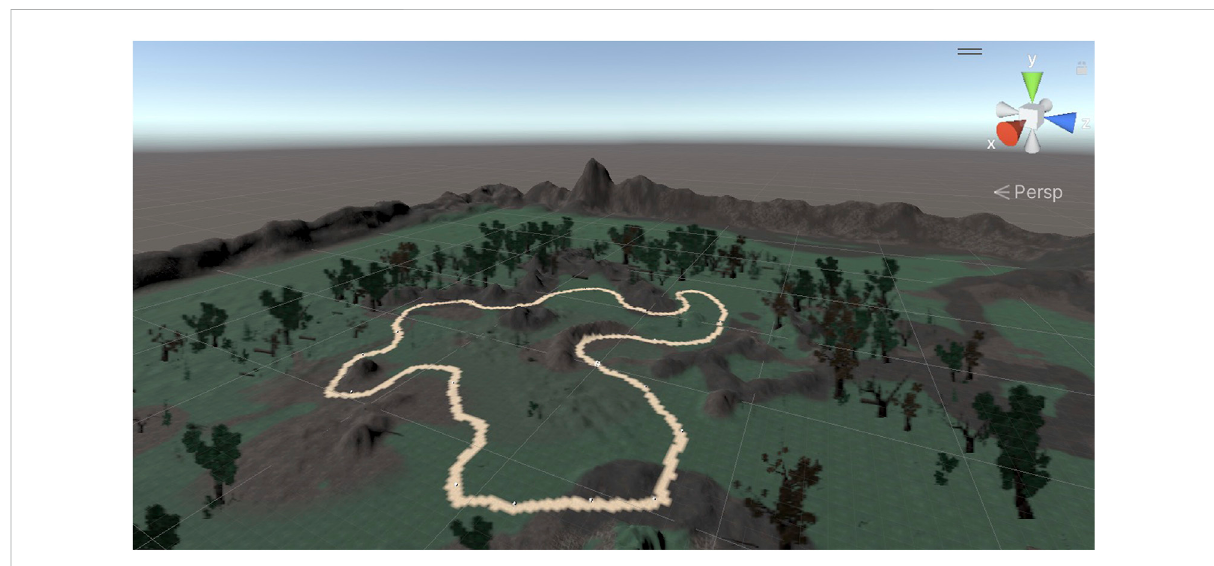
FIGURE 4 Virtual navigation environment used through the experiment. The highlighted line shows the navigation path.